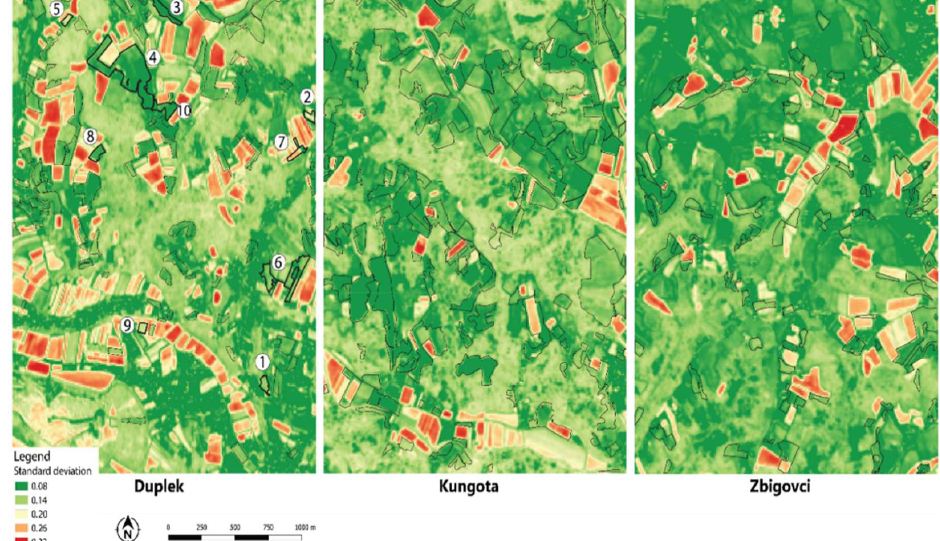
Figure 11. NDVI standard deviation calculated on all three study areas. Permanent meadows are outlined in black. The ten objects for which the main verification was carried out (for the needs of visual representation of results in this paper) are highlighted in the Duplek example ( left ).